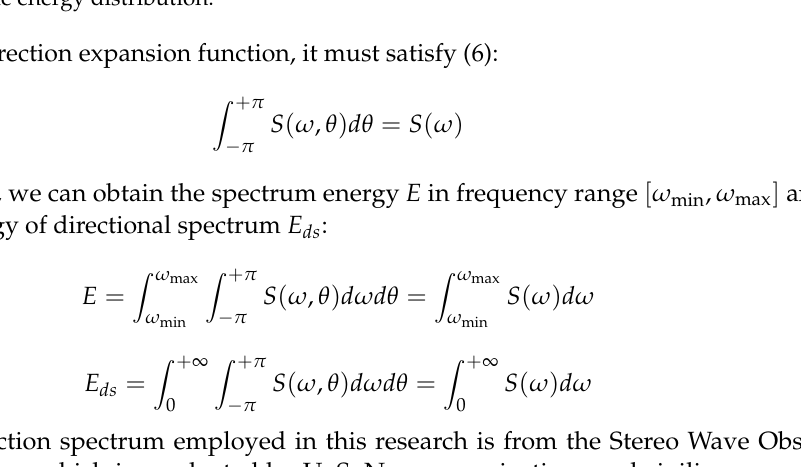
Figure 2. Energy distribution under different wind speeds. The higher the wind speed is, the more concentrated the energy distribution.